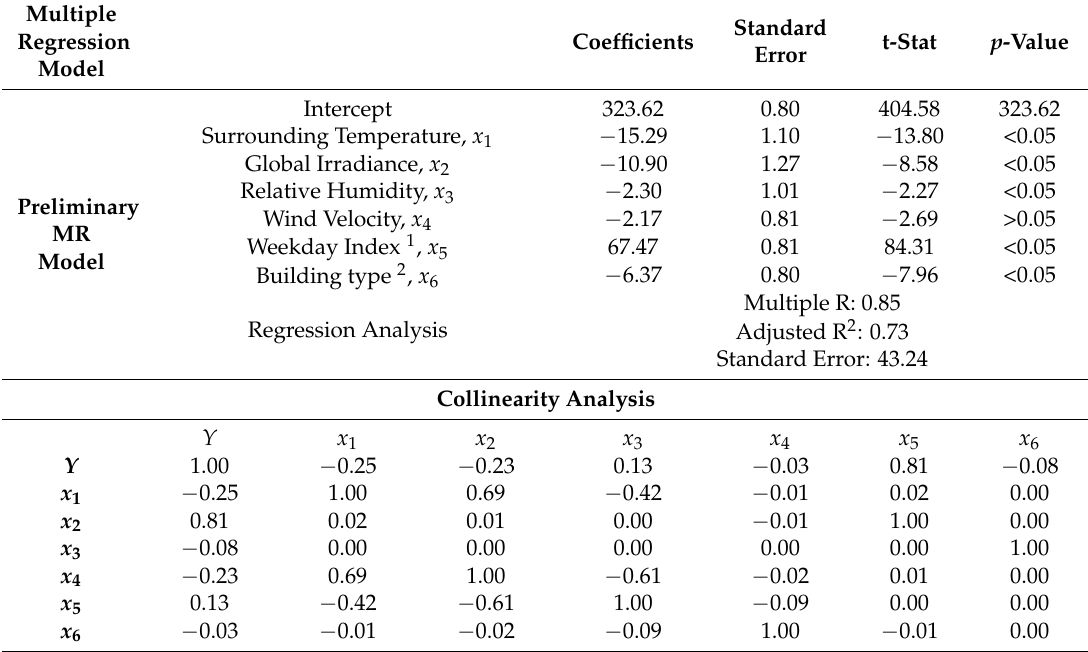
Table 5. Preliminary MR Model and Collinearity Analysis.